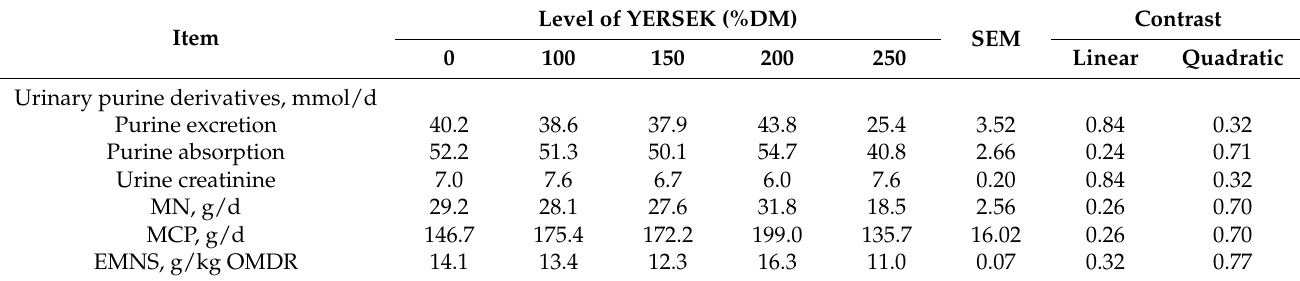
Table 6. Effect of YERSEK on microbial protein synthesis in dairy